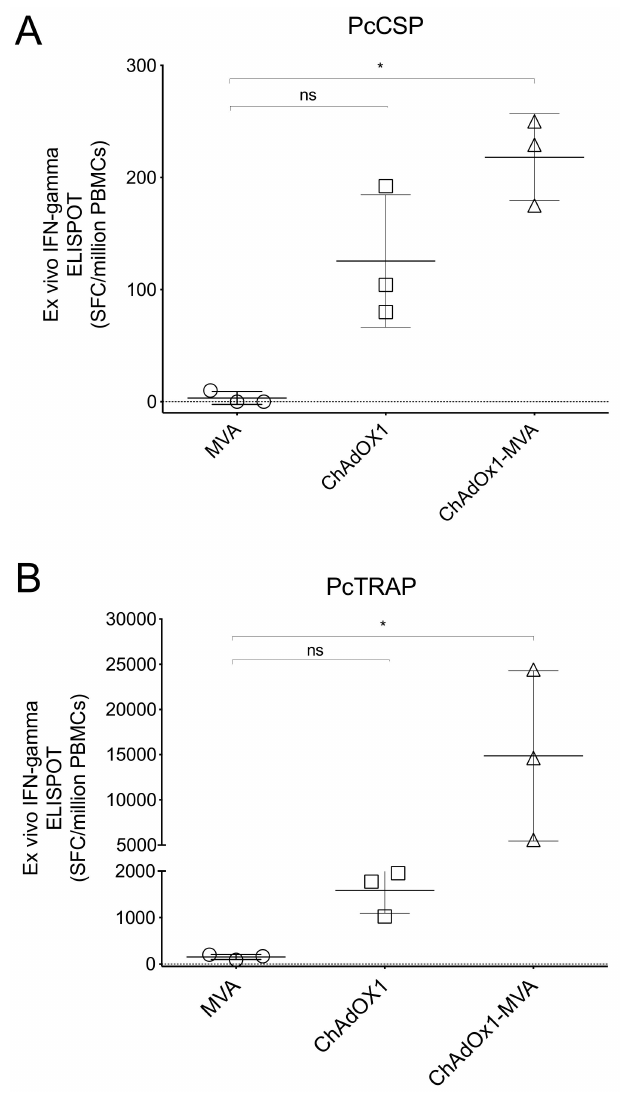
Figure 3. Cellular immune responses elicited by ChAdOx1 and MVA vaccines. C57Bl / 6 mice ( n = 3 per group) were injected with either ChAdOx1 PcCSP or ChAdOx1 PcTRAP at a concentration of 1 × 10 8 IU / mouse, and MVA PcCSP and MVA PcTRAP at concentrations of 1 × 10 6 PFU / mouse. A heterologous Prime-Boost using ChAdOx1-MVA vaccination regimen was also tested. Peripheral blood mononuclear cells (PBMCs) were cultured with peptide pools spanning the PcCSP and PcTRAP proteins and responses were assessed using an ex vivo IFN-gamma ELISpot. Values represent the spot-forming cells (SFC) per million PBMCs resulting from stimulation with 20-mer overlapping by 10 peptides spanning the whole PcCSP ( A ) and PcTRAP ( B ) structural proteins (10 µ g / mL). Line shapes represent mice vaccinated with each vaccine. p -values were determined by Kruskal–Wallis test and Dunn’s multiple comparisons test. p > 0.05 (ns), p < 0.05